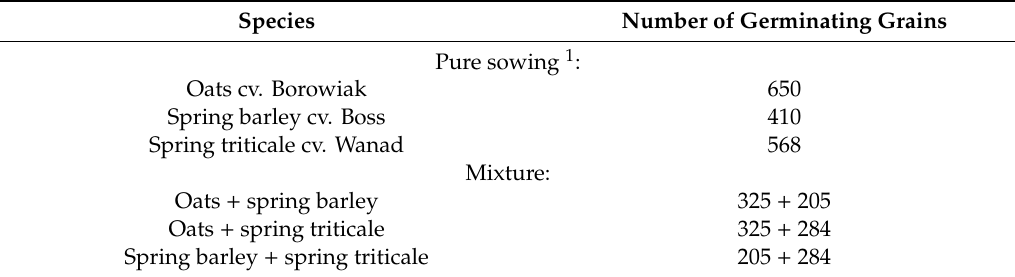
Table 1. Species composition and number of grains (pcs. m -2 ) for pure and mixed sowings of spring cereals. Species Number of Germinating Grains Pure sowing 1